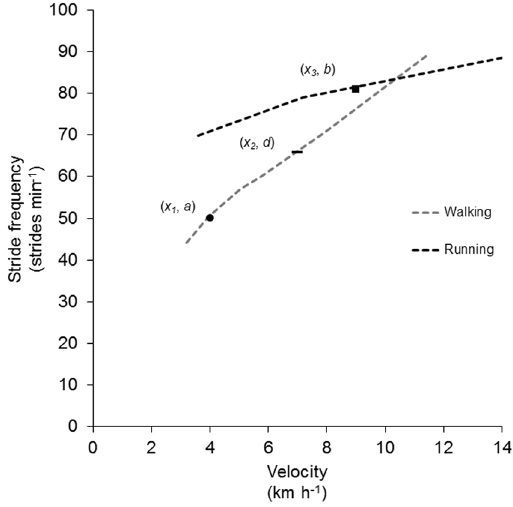
Figure 1. Illustration of the underlying justification for the predicted transition stride frequency in the present study. Broken lines represent the common relationships between freely chosen stride frequencies and velocity during walking and running at ranges of pre-set velocities. The lines were produced using experimentally collected mean data from 10 participants 48 . Hypothetical data points are inserted to represent a single individual during unrestricted gait conditions of walking (black filled circle) and running (black filled square) at freely chosen velocities and freely chosen stride frequencies. The stride frequencies (i.e. y -coordinates) applied during these two gait conditions were considered behavioural attractors. The rationale for the predicted transition stride frequency was as follows: When walking at increasing velocity, individuals shift from walking to running when the stride frequency starts getting closer to the attractor “ahead” than to the attractor “behind”. Accordingly, the predicted transition stride frequency ( d ) for the hypothetical individual in this case constitutes the y -coordinate of the superimposed data point of the short black horizontal